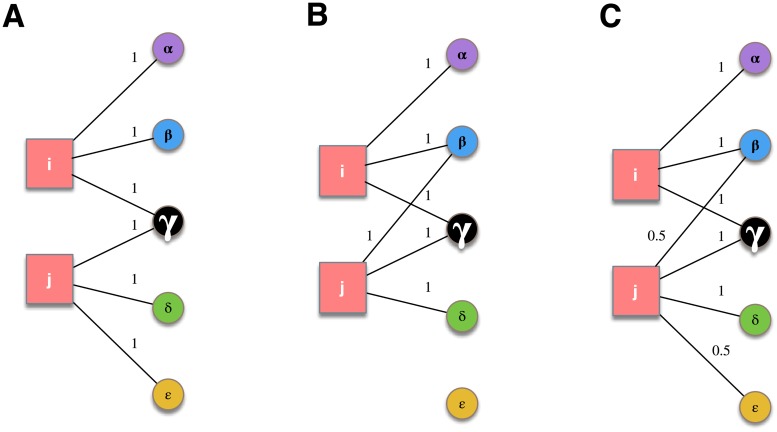
Three case studies, with the same values of the portfolios (Si = Sj = 3) but different values of the inverse Herfindahl-Hirschmann index and of the cosine similarity between them.